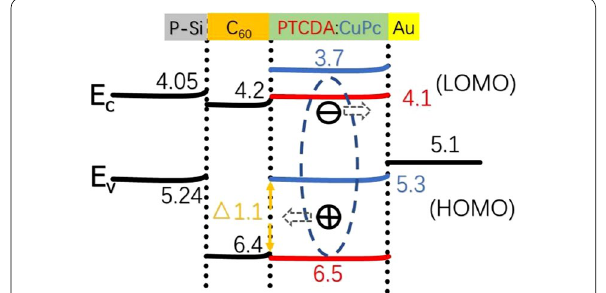
Fig. 6 The energy level diagram and charge generation kinetics and transport mechanisms